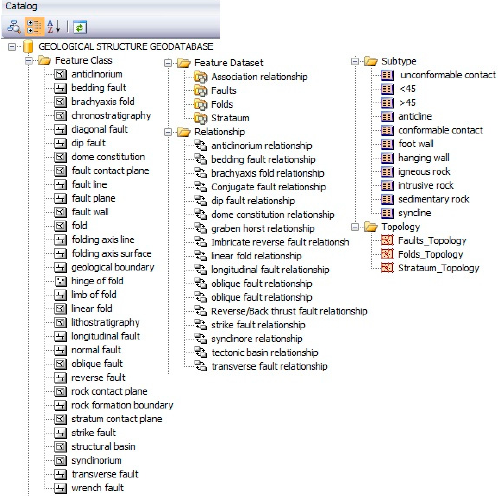
Figure 11. Physical storage of the geological relationship model.